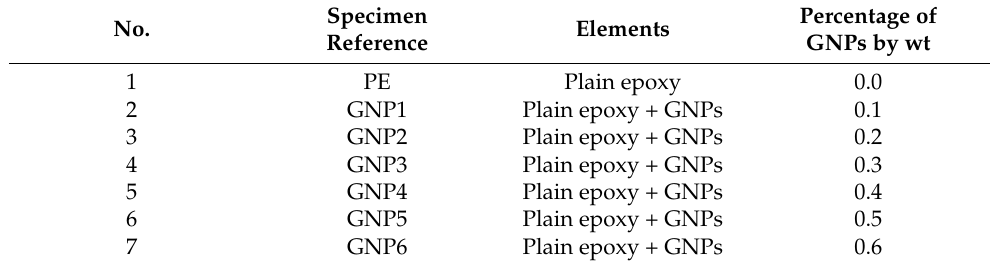
Table 2. Test specimen details (Epoxy +